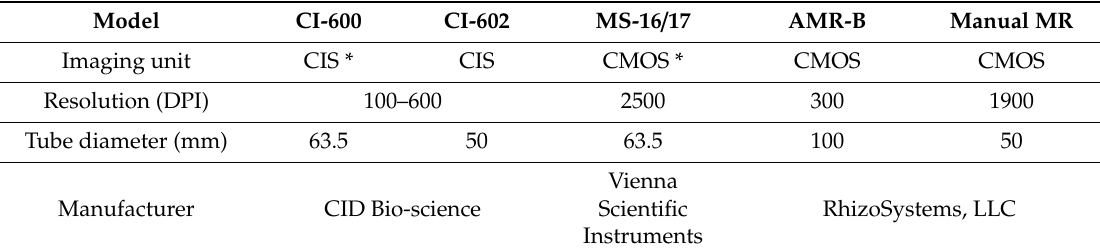
Table 1. Imaging techniques and tube diameters in commercial